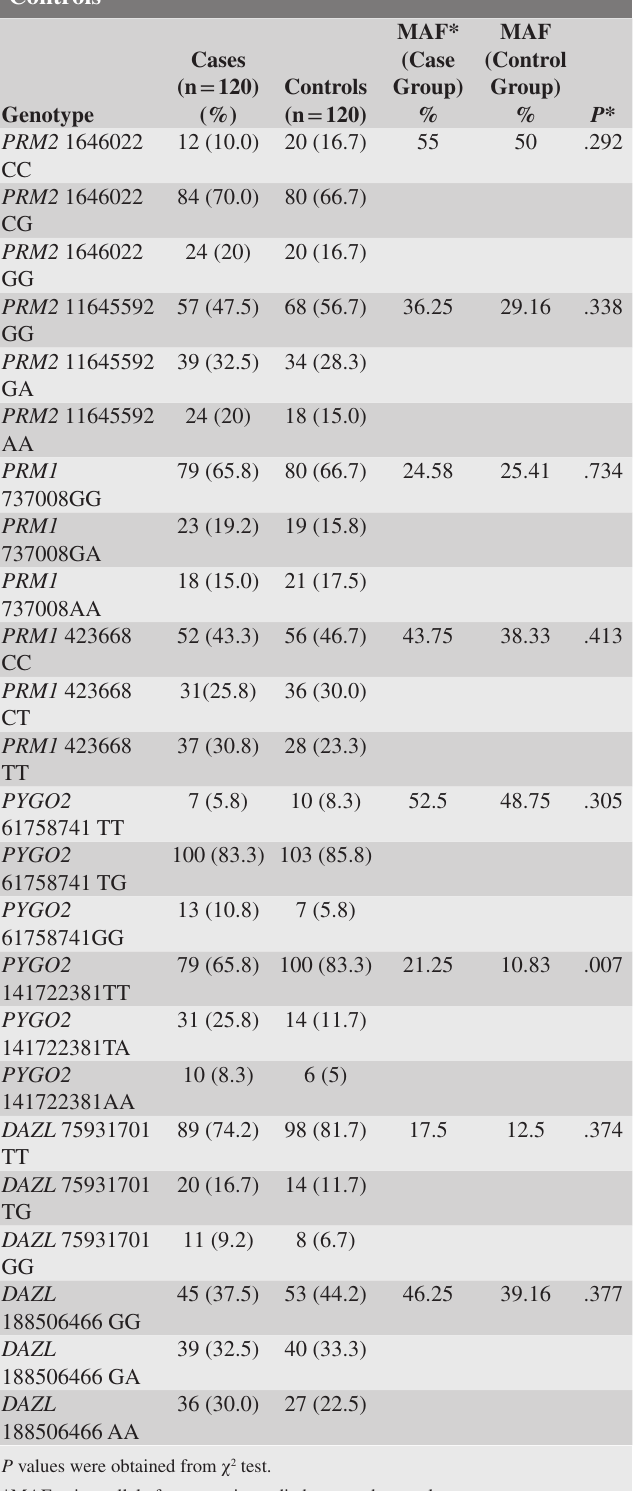
Table 3. Allele Frequency and Distribution of the PRM2 , PYGO2 , and DAZL Genotypes in Infertile Patients and